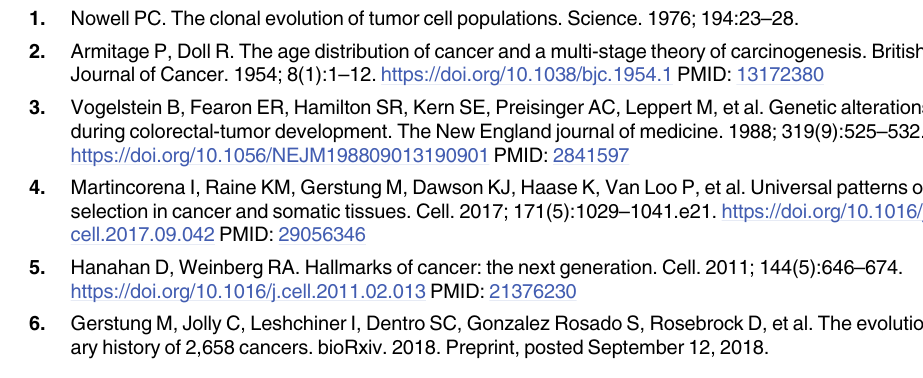
S1 Fig. Waiting times for tumour progression: Case no decline. Isocontours for waiting times for tumour progression (2 1 , . . . , 2 16 , upmost contours representing smaller values) from Eqs 2–6 with two turnover values, high ( β = 1.0, δ = 0.6) and low ( β = 0.42, δ = 0.02), and 0 0 0 0 therapy magnitude Δ = 0.2. A no treatment B cytostatic treatment and C cytotoxic treatment. Simulation results, 10 4 independent runs per μ , γ pair, are shown in dashed lines. Analytical and simulation results closely agree until about Kμ , K γ � 0.01 − 0.1 when the time-scale sepa- ration argument starts to break down. We note that the longest waiting time isocontours are underestimated by the simulations due to our stopping condition at 10 5 steps which truncates an increasing number of the 10 4 independent runs at very small values of Kμ + K γ < 10 − 4 .